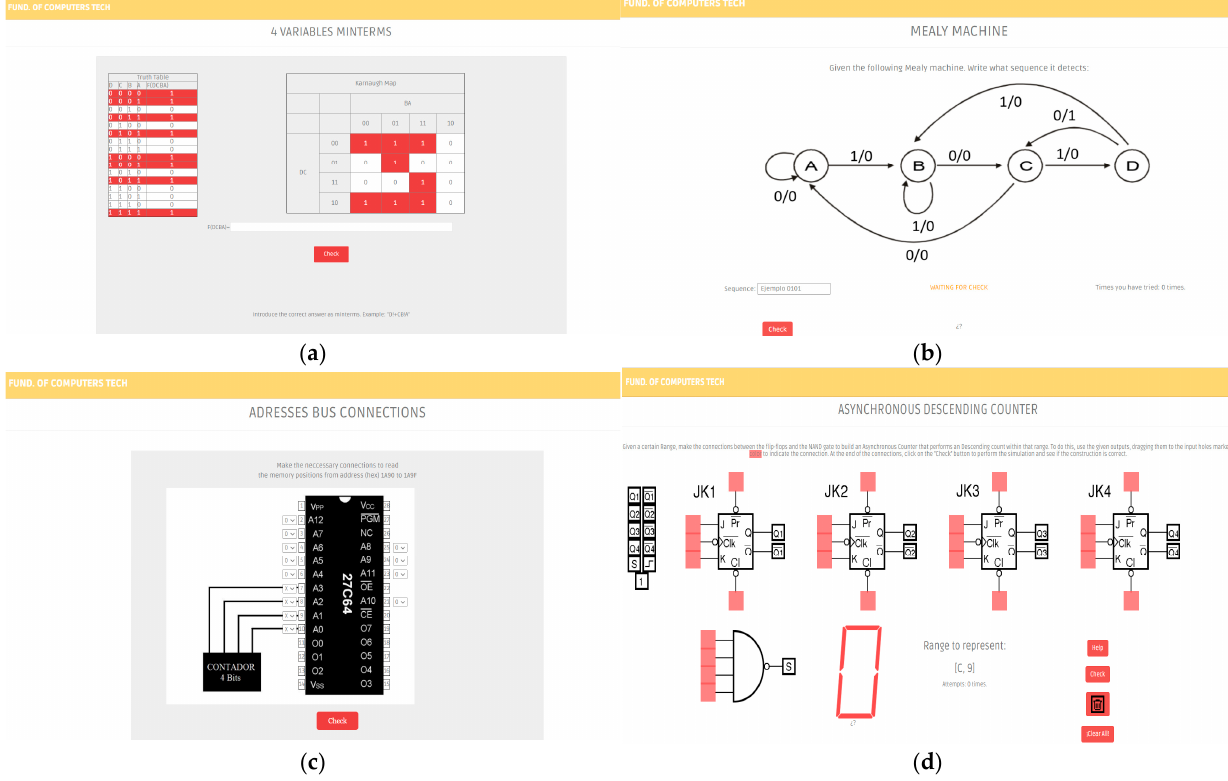
Figure 1. Example of OLE interactive activities randomly generated. ( a ) Karnaugh Maps, min terms, ( b ) example of sequential circuit: asynchronous counter with JK bistables, ( c ) example of memory system circuit: addresses bus connections, and ( d ) example of finite state machine graph: Mealy.